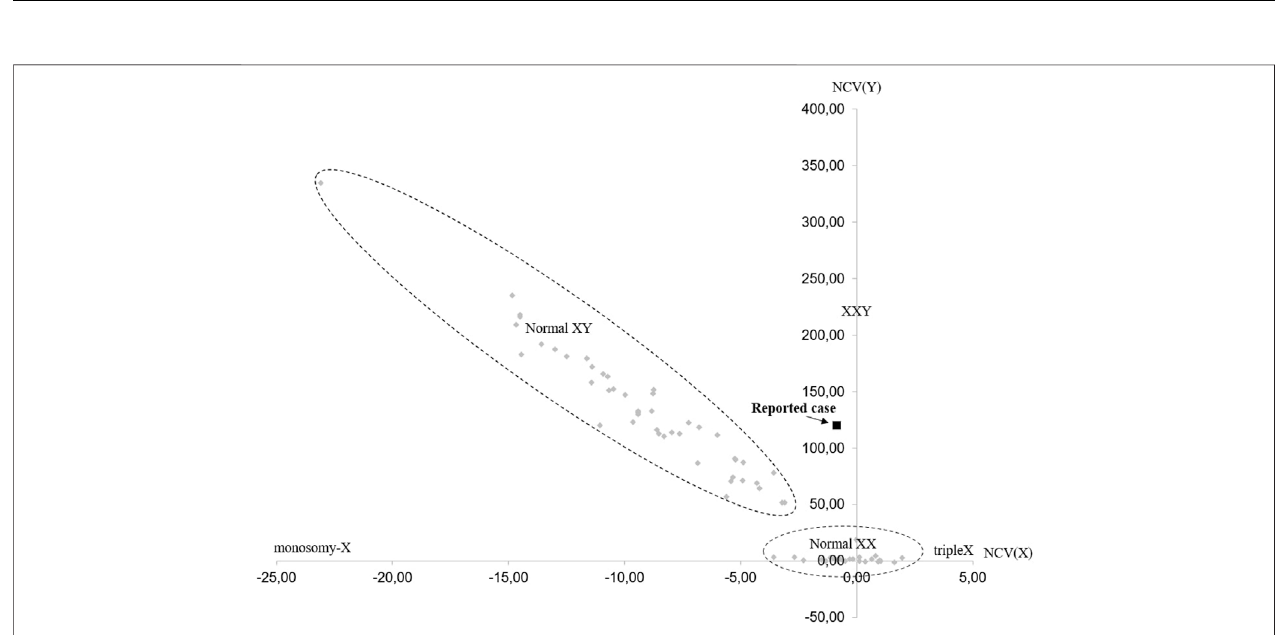
FIGURE 3 | Cell-free NIPT result for chromosome X and chromosome Y. The horizontal axis represents the normalized level of X-chromosomal material [NCV(X)], and the vertical axis represents levelofY-chromosomal material detected [NCV(Y)]. The normal range forfemale euploid samples(Normal XX)and maleeuploid samples (Normal XY) are marked by the dotted lines. The cell-free NIPT result for the reported case is marked with a black square. The cell-free NIPT result suggests a 47,XXY karyotype in at least one of the fetuses. NCV = Normalized Chromosome Value (for chromosome X and chromosome Y, respectively).